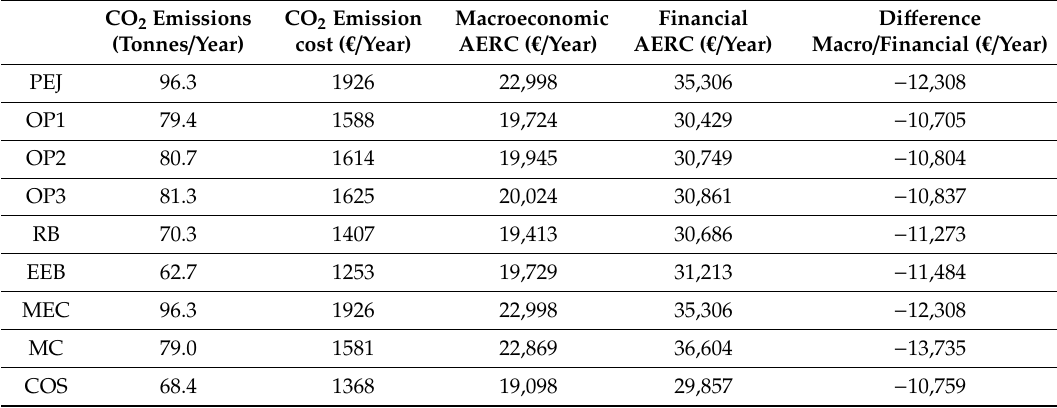
Figure 6. Annualized energy-related costs against primary energy demands for more representative EEMs analyzed for the colder climatic zone F, including a macroeconomic projection. Table 13. CO 2 emissions and corresponding cost for the EEMs considered and comparison between the annualized energy-related costs (AERC) determined for the financial and macroeconomic projections in the cold